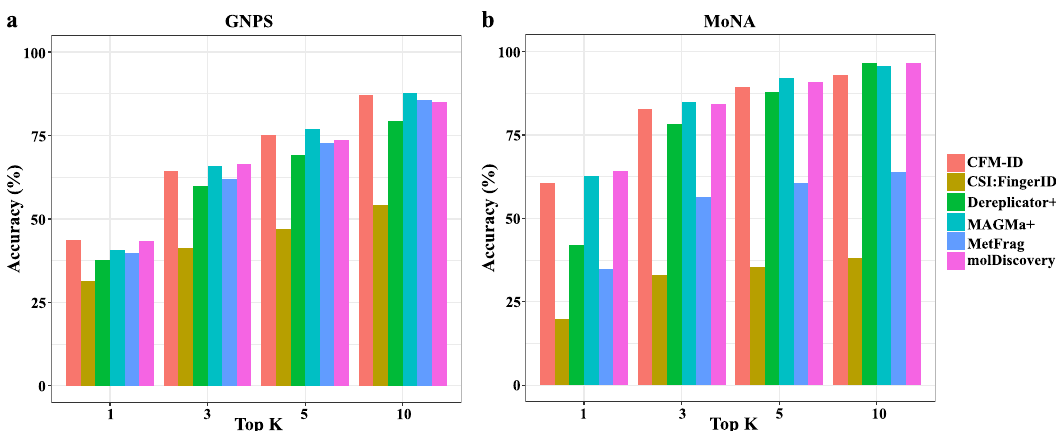
Fig. 3 Top K = 1, 3, 5, and 10 accuracy for all tested methods. a Searching 194 spectra from the GNPS spectral library against 77,057 molecules from DNP and b Searching 342 spectra from MoNA against 10,124 molecules from MoNA (spectra from molecules overlapping with CSI:FingerID training data are removed). Ties in scores were evaluated by setting the rank of the candidate compounds with tied scores to the average of all of those ranks. See Supplementary Note 1 for detailed parameter settings of these methods. Table 1 Running time and peak memory usage of all methods in searching GNPS against DNP.